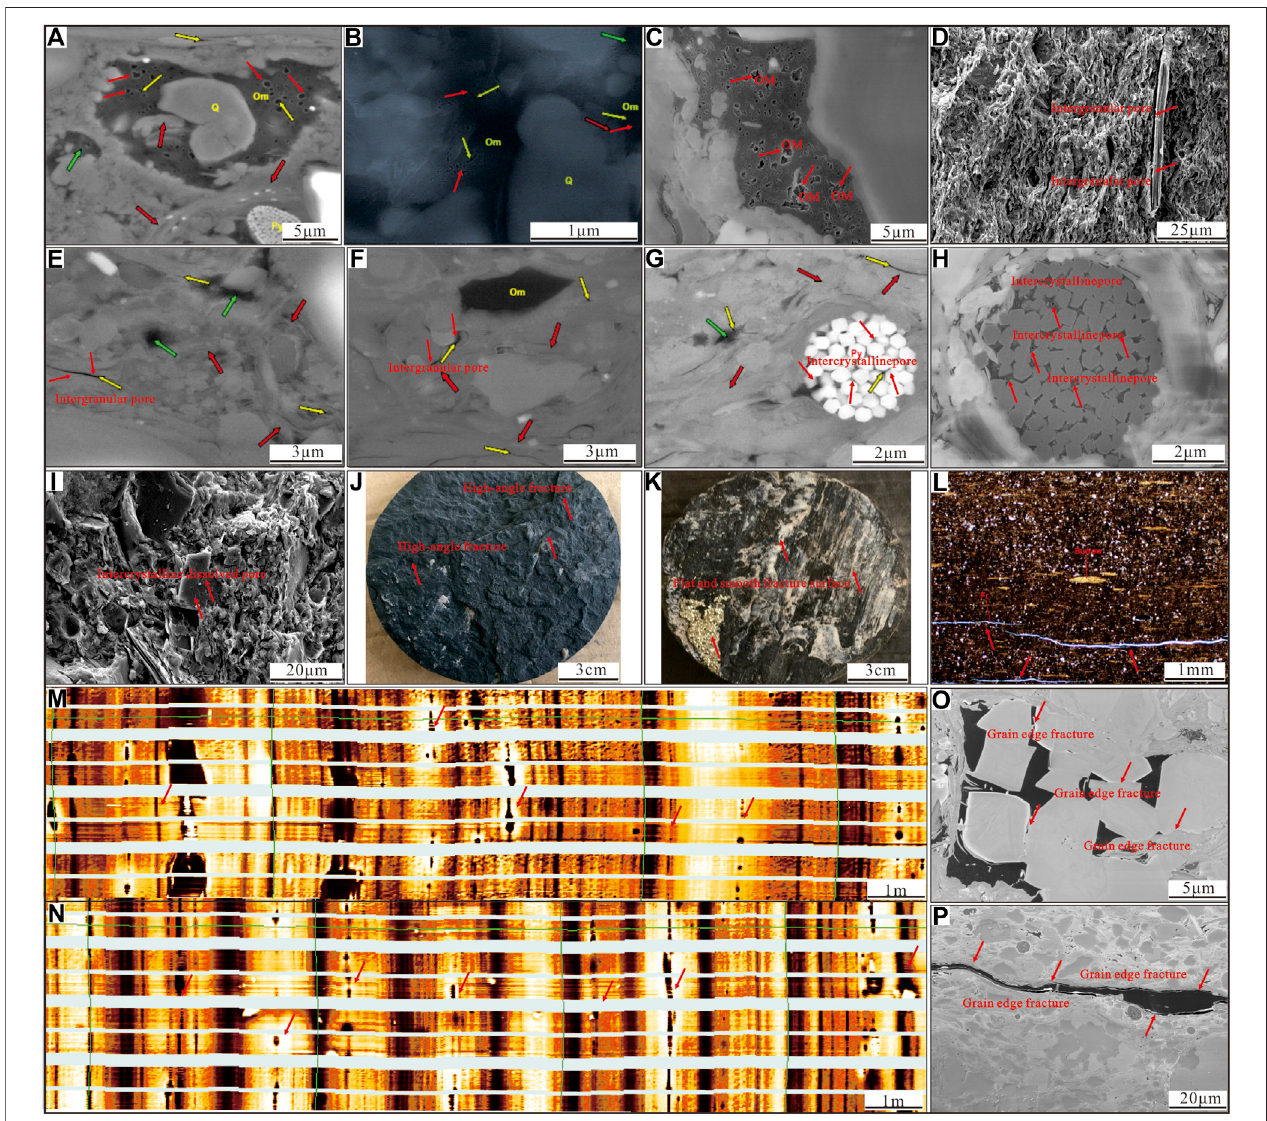
FIGURE 5 | Reservoir space types and characteristics of the Long 1 1 sub-member in the study area. (A) . W206, 3,787.53 m, Micropores in organic matter. (B) . W206, 3,765.52 m, Micropores in organic matter. (C) . R233H, 3,884.35 m, Organic matter pore, The pores are round-oval. (D) . W206H2, 3,782.52 m, The intergranular pores are lamellar. (E) . W206, 3,771.81 m, Flaky intergranular pores between clay particles. (F) . W206, 3,781.76 m, intergranular pores. (G) . W206, 3,787.53 m, Intercrystalline pores in pyrite particles. (H) . W231, 3,878.92 m, Intercrystalline pores in pyrite particles. (I) . R233H, 3,893.50 m, Intercrystalline dissolved pores. (J) . W231, 3,878.85 m, Vertical fracture, un fi lled. k. R233H, 3,885.27 m, Calcite can be seen on the fracture surface, and there are scratches on the fracture surface. (L) . W206, 3,753.86 m, Microcracks parallel to clay bedding. (M,N) , characteristics of bedding fractures in the imaging logging. (O) .